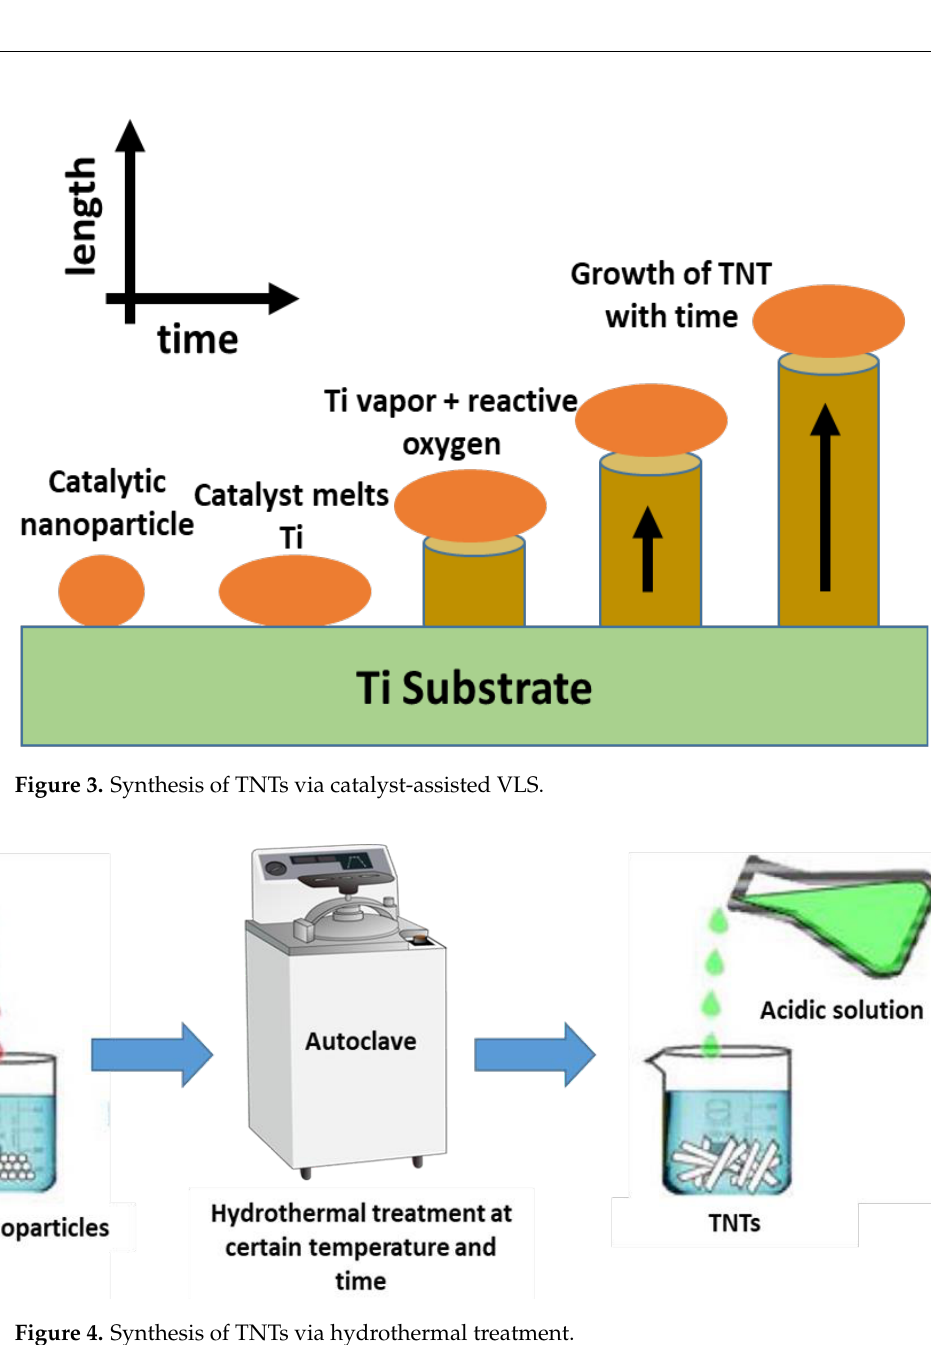
Figure 4. Synthesis of TNTs via hydrothermal treatment .